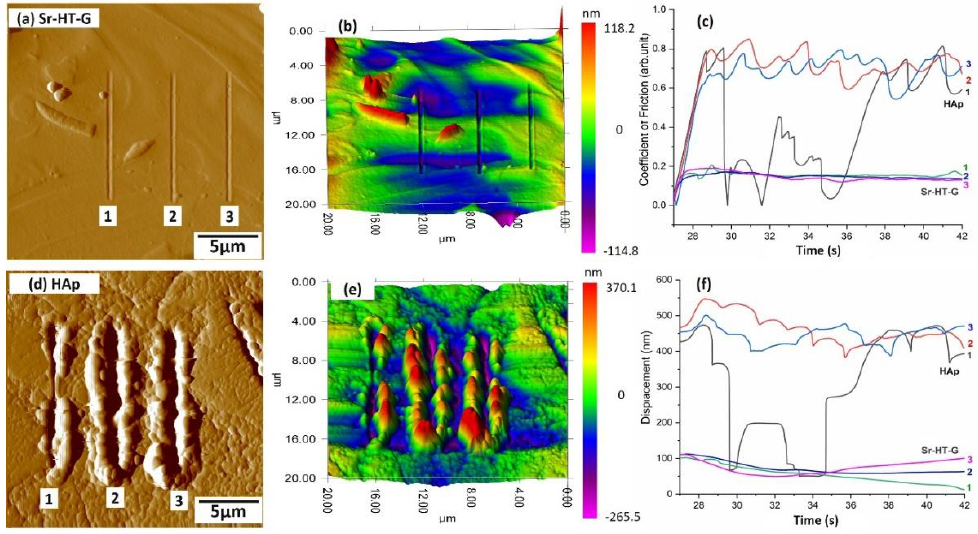
Figure 10. Nanoscratch test results of the Sr–HT–G coating ( a , b ); and the HAp coating ( d , e ); friction coefficient ( c ); and normal displacement ( f ).